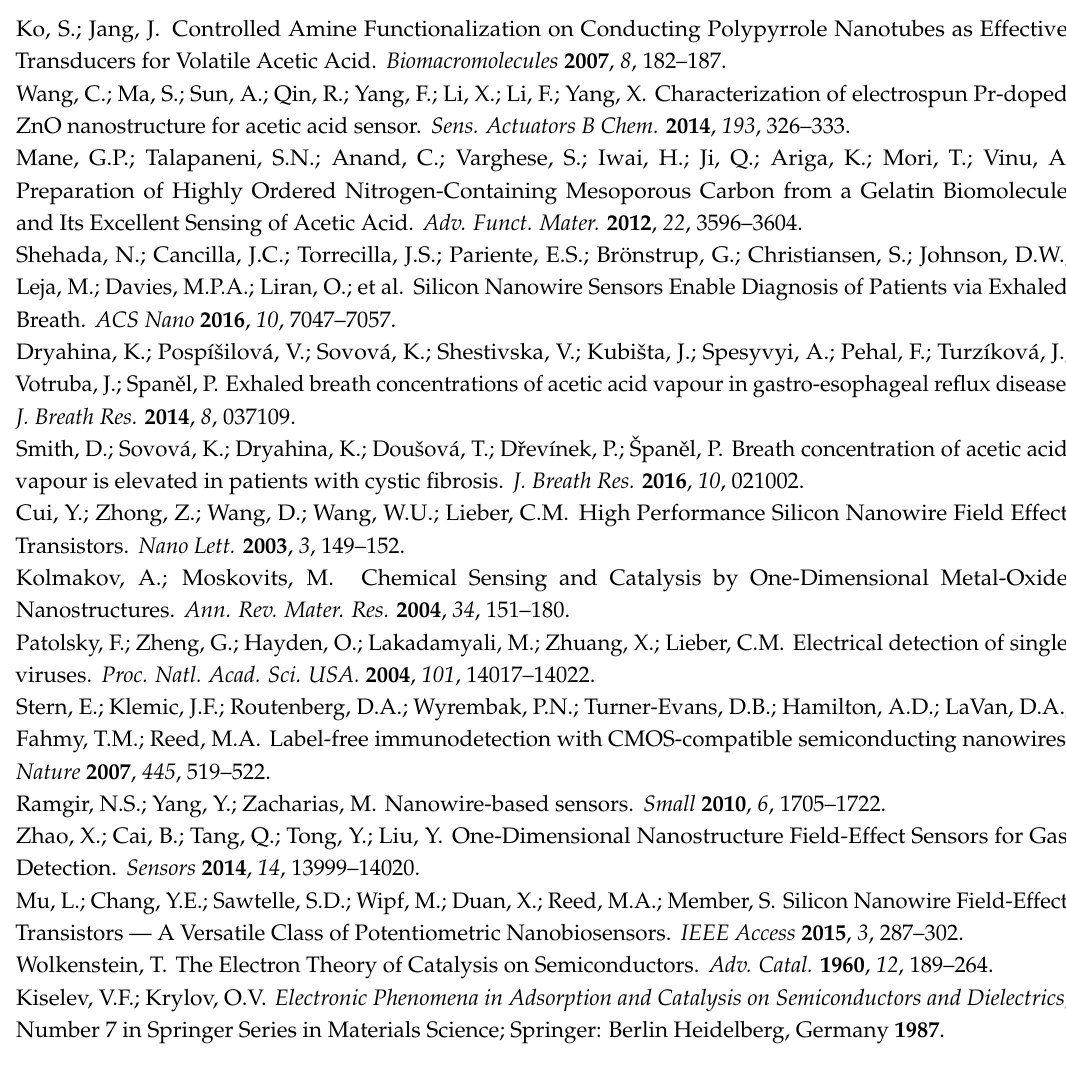
Figure S1: Transient current in acetic acid at V GS = − 1V, Figure S2: Semi-log plots of transfer curves, Figure S3: Continuous transient current measurement from Figure